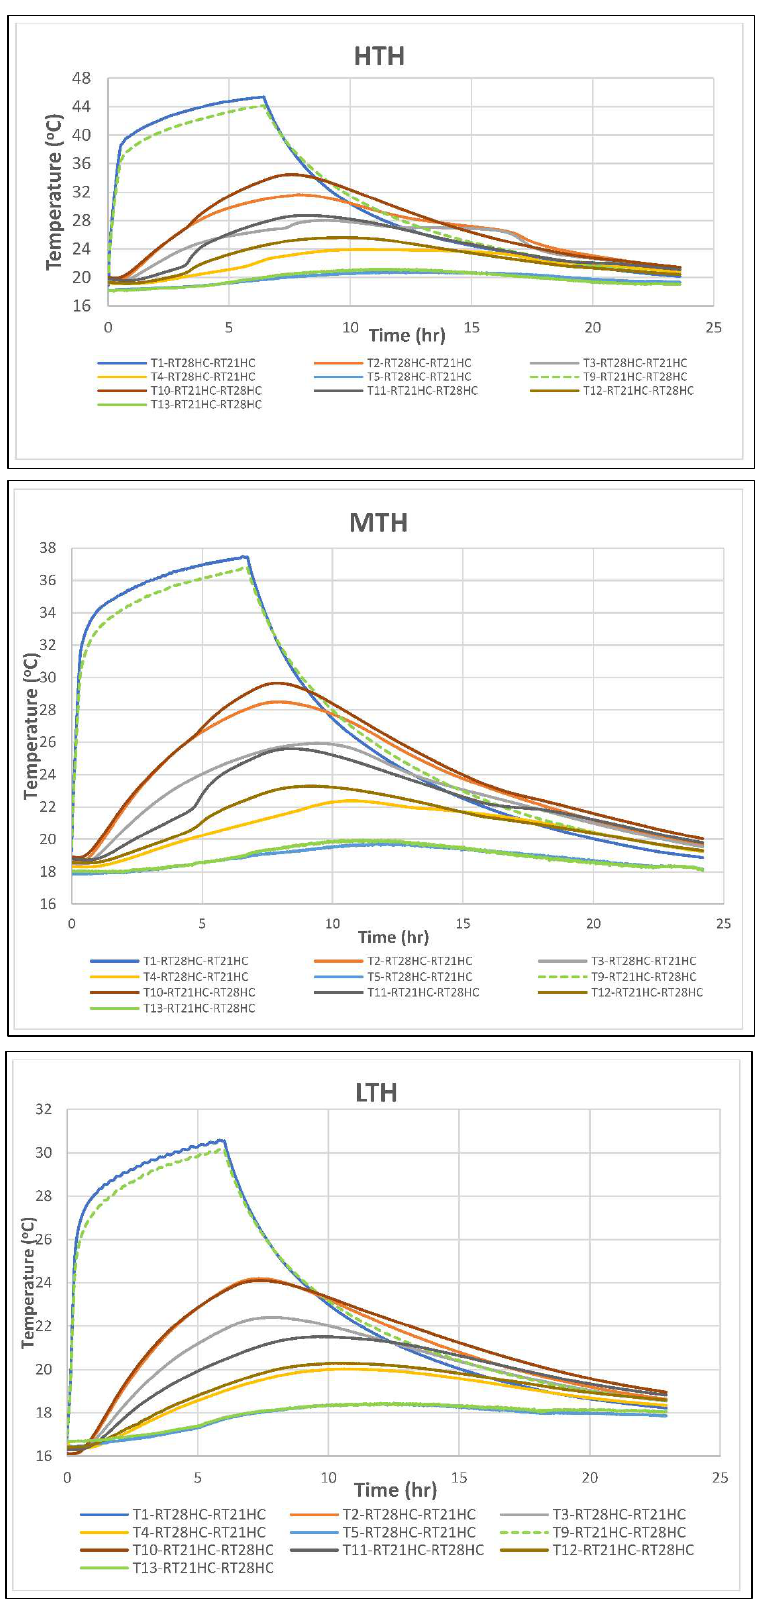
Figure 11. Temperature distribution for concrete samples integrated with PCMs RT28HC–RT21HC and RT21HC–RT28HC. The proposed hybrid configurations, either RT28HC–RT21HC or RT21HC–RT28HC, covered a wider phase change temperature range and, thus, offered better thermal comfort and energy storage potential than the configurations described earlier in Figure 9. In Figure 11, for HTH, the maximum temperatures at the sample top were 20.7 °C and 21.2 °C, for MTH, peak values were 19.7 °C and 20 °C and, in LTH, the highest temperature was 18.4 °C